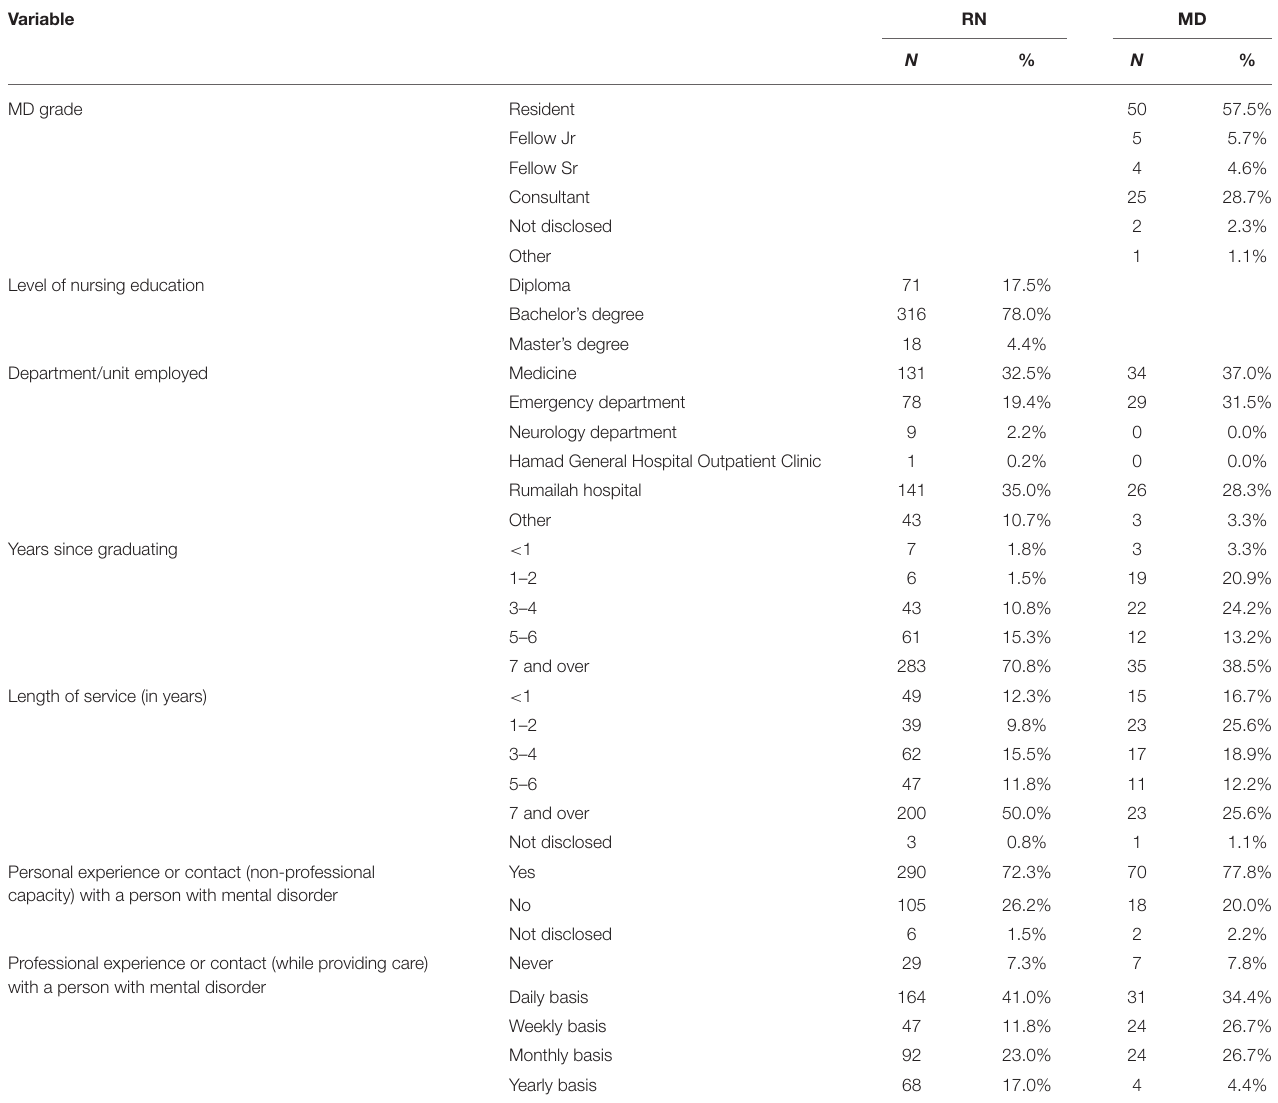
TABLE 2 | Participants’ professional background characteristics.